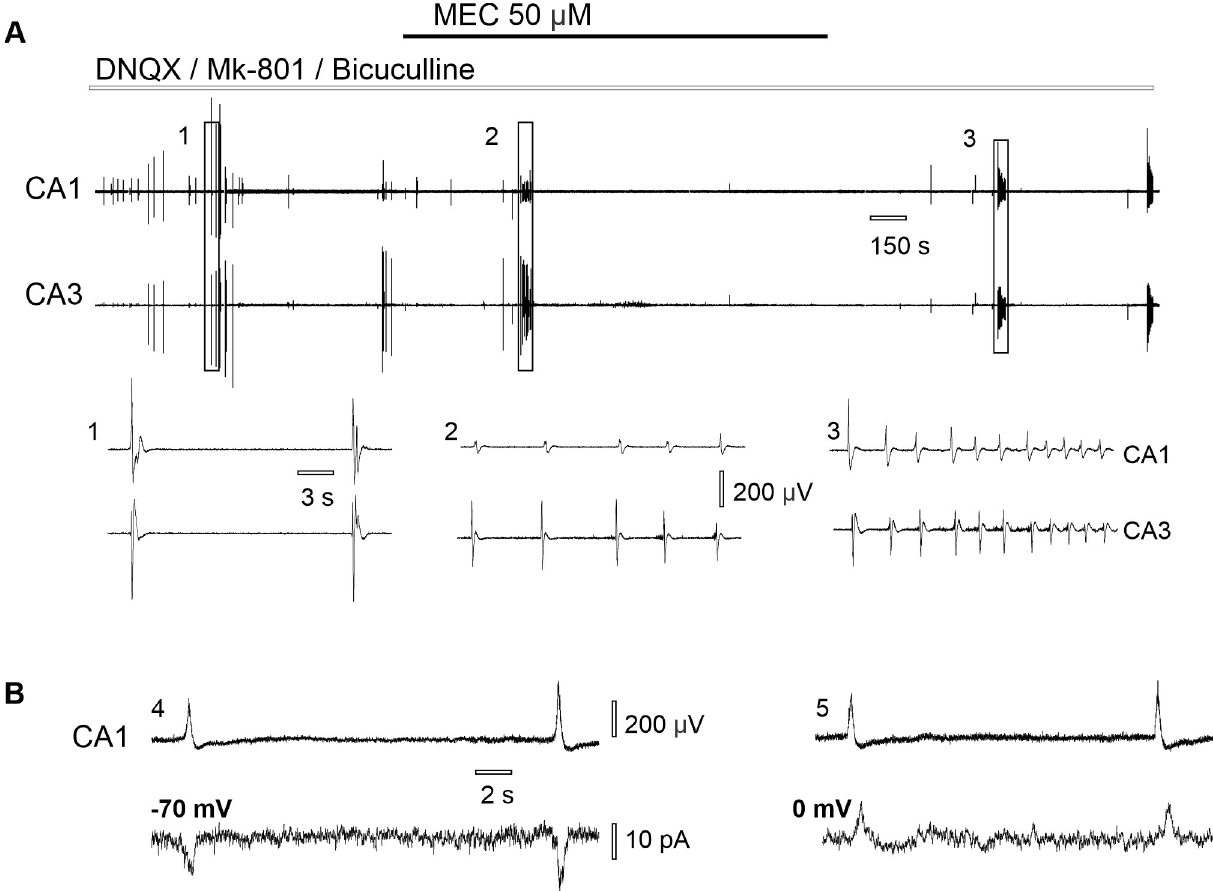
Fig 5. Nicotinic receptors contribute to synchronous discharges in synaptic blockers aCSF. (A) Effect of nonselective nicotinic antagonist mecamylamine on CA3-CA1 synchronous epileptiform discharges induced in synaptic blockers aCSF: (1) single epileptiform discharges; (2) decrease in epileptiform discharges following 50 μ M MEC application; (3) epileptiform discharges after mecamylamine wash out. (B) Simultaneous extracellular (up) and patch clamp recording (bottom) in synaptic blockers aCSF: (4) neuron voltage clamped at -70 mV, (5) neuron voltage clamped at zero mV.